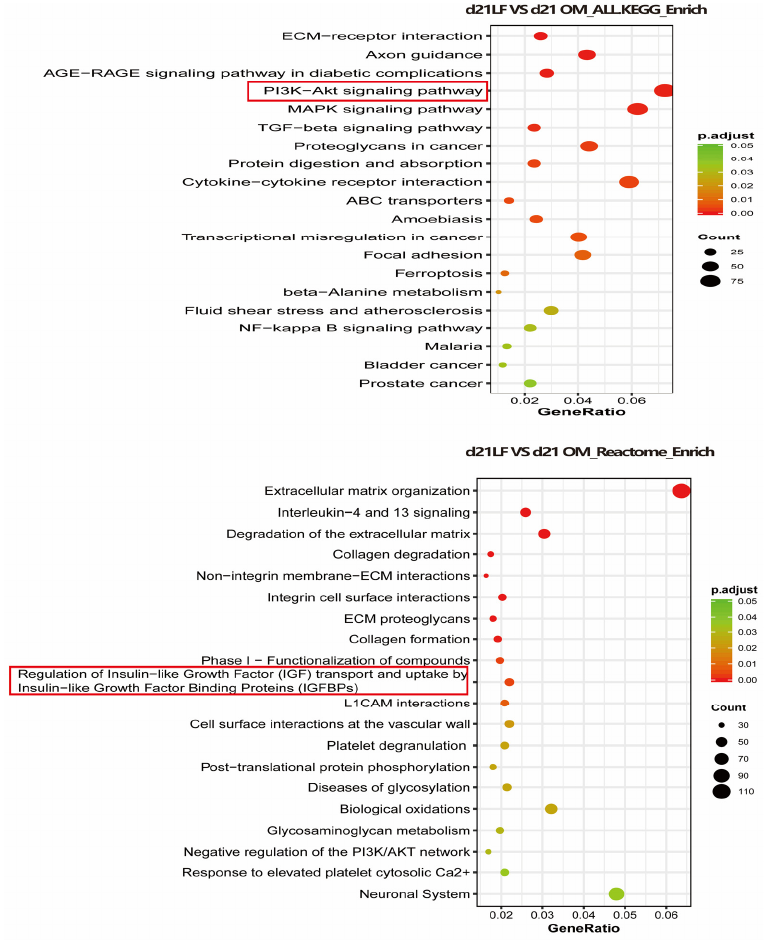
Figure 6. Transcriptome sequencing was performed on hADSCs of OM + LF 100 μ g/mL and OM group on day 21 of osteogenic differentiation, and KEGG and Reactome enrichment of differential genes was performed. The 20 signaling pathways with the most significant changes were obtained. Red and green symbols represent up- and downregulation, respectively.